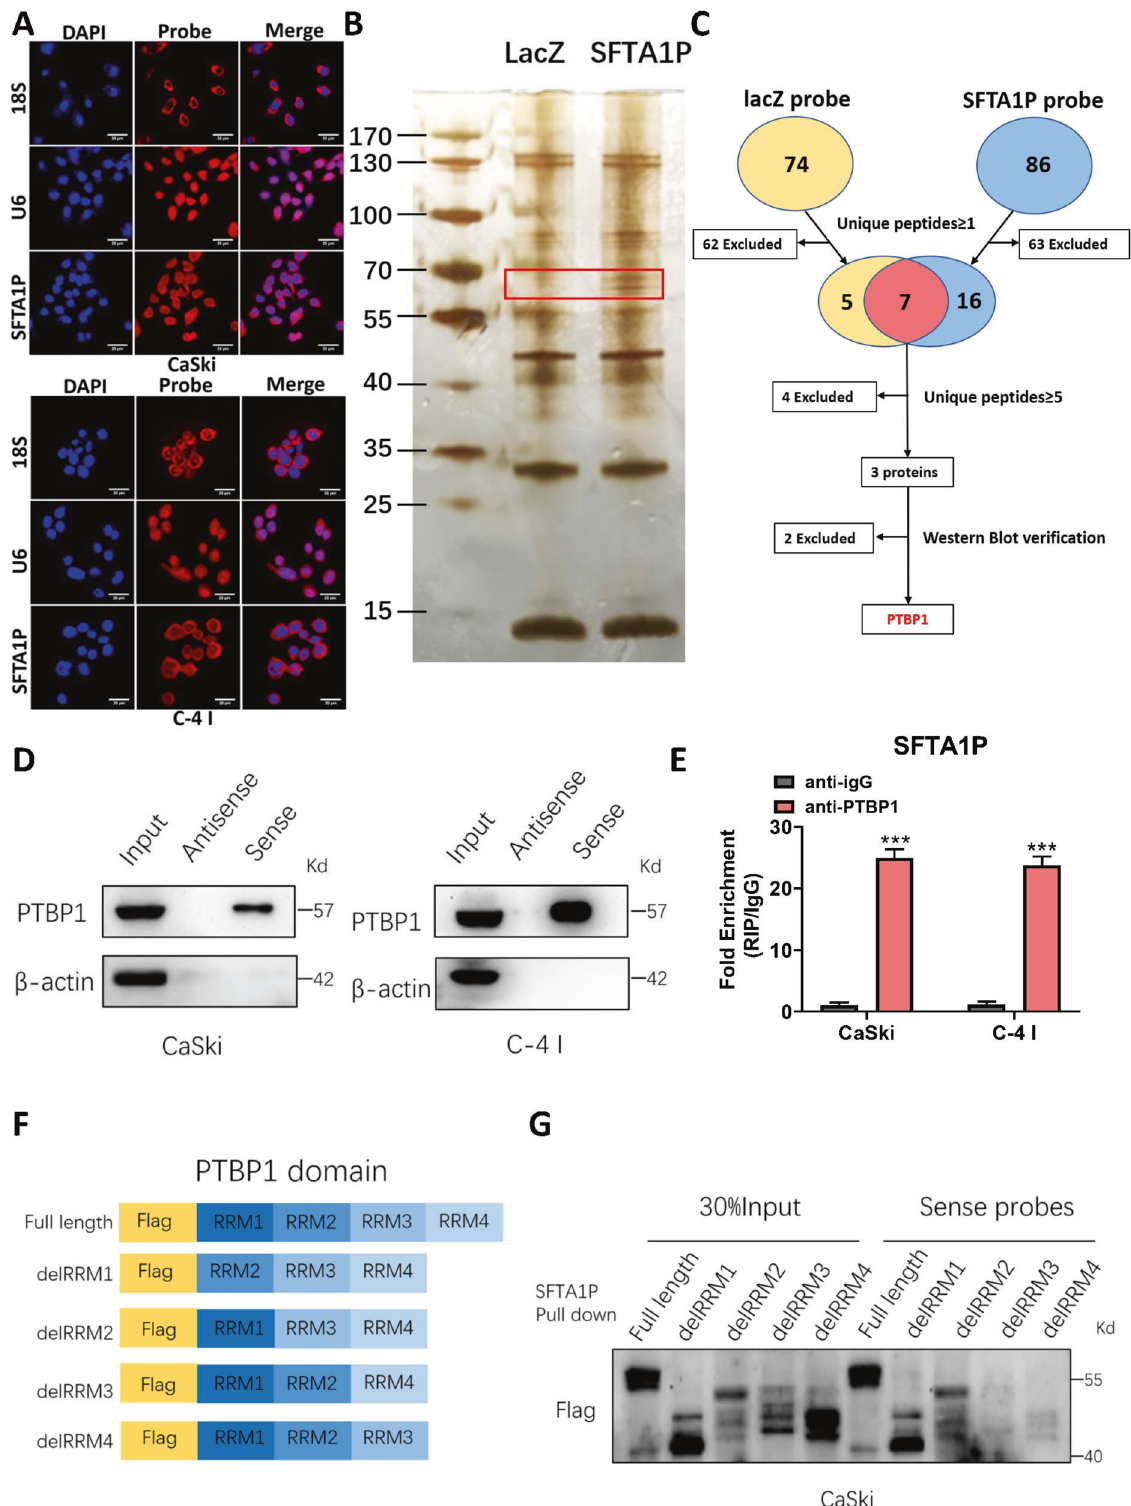
Fig. 4 SFTA1P interacts with PTBP1 in cervical cancer cells. A The localization of SFTA1P in the cytoplasm of CaSki and C-4 I cells by RNA- FISH assays. Scale bar, 20 μ M. B Potential proteins pulled down by SFTA1P or lacZ probes in C-4 I cells. The red box indicates distinct protein bands between SFTA1P or lacZ probes. C Flowchart for identifying proteins that interact with SFTA1P. D Western blot analysis of PTBP1 in sense and antisense SFTA1P pull-down fractions from CaSki and C-4 I cells. E RNA immunoprecipitation (RIP) assay with antibody PTBP1 in CaSki and C-4 I cells. The relative fold enrichment of SFTA1P between PTBP1 and IgG RIP fractions was measured by qRT-PCR. F The schematic domain structure of PTBP1 and four domain deleted mutants. G Truncated RRM domains were detected by RNA pull-down, followed by western blot con fi rmation. Data are shown as mean ± SEM. * P < 0.05; ** P < 0.01; *** P < 0.001.